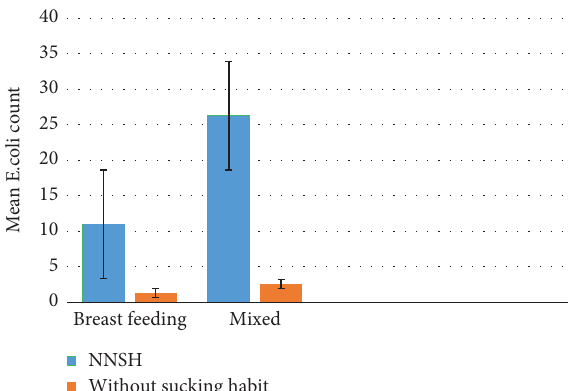
Figure 2: Mean E. coli count between the two groups according to type of feeding.